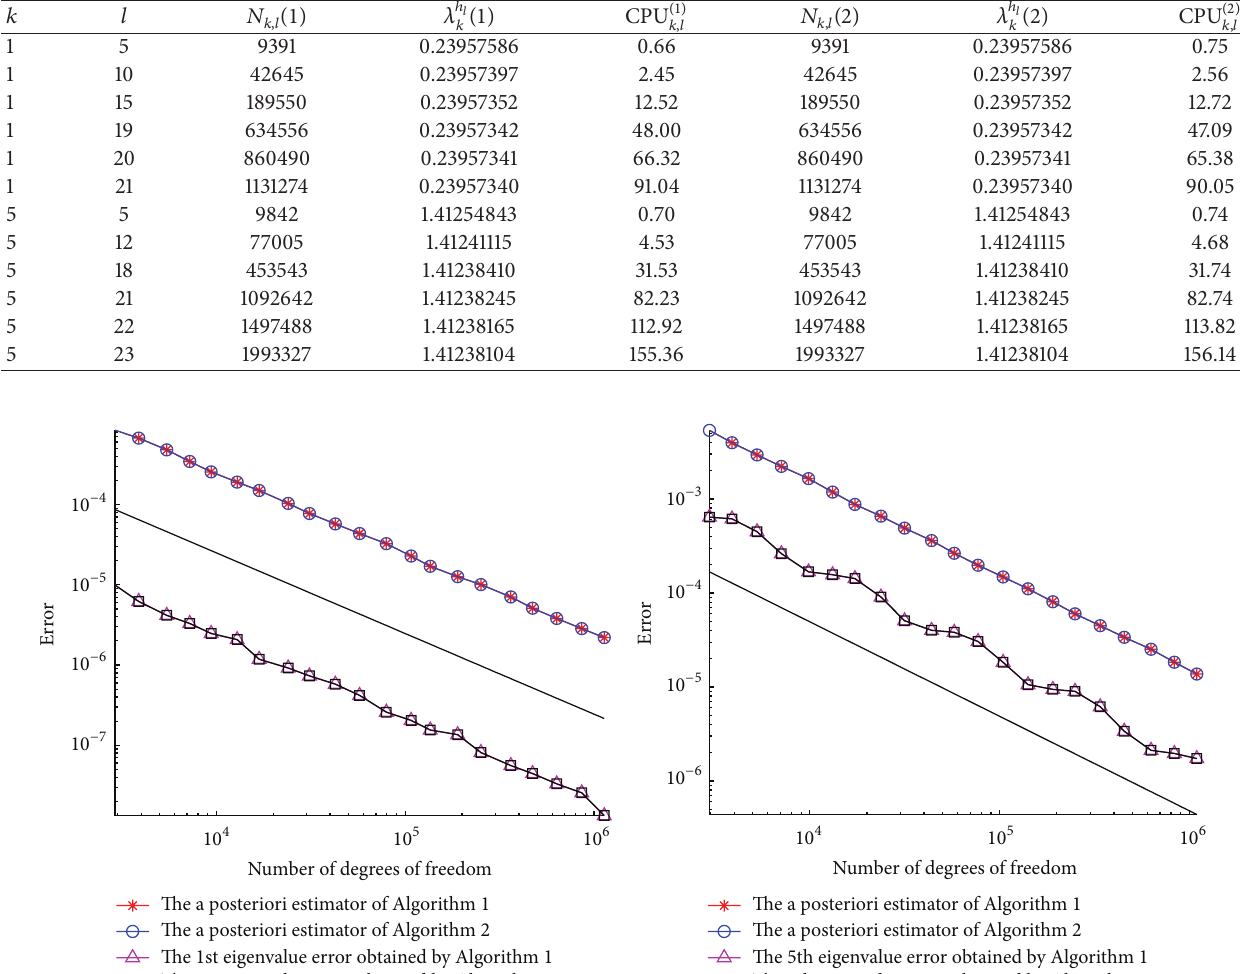
Table 3: The 1st and 5th eigenvalues of Example 3 obtained by two algorithms with 𝐻 = √2/32 .